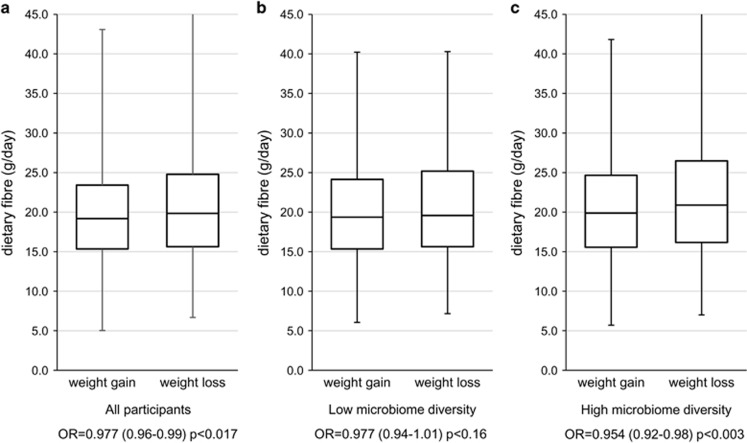
Box plot showing the relationship between dietary fibre intake and weight gain/weight loss (a) overall, (b) in individuals in the bottom tertile of Shannon’s diversity index and (c) in the top tertile of Shannon’s diversity index. The ORs for association with weight gain per gram per day of fibre intake are also shown.